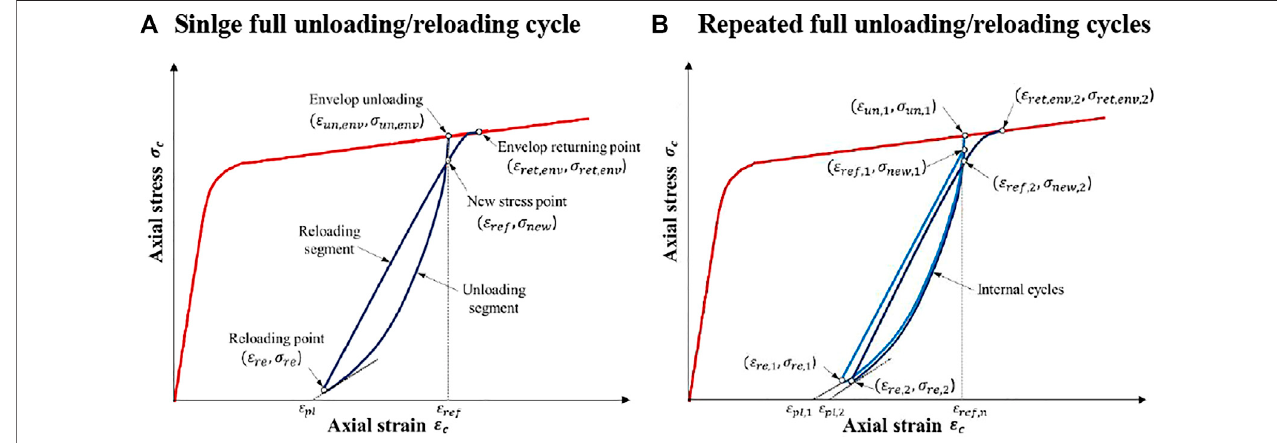
FIGURE7| SchematicviewofLamandTeng ’ smodel(LamandTeng,2009). (A) Singlefullunloading/reloadingcycle. (B) Repeatedfullunloading/reloadingcycles.